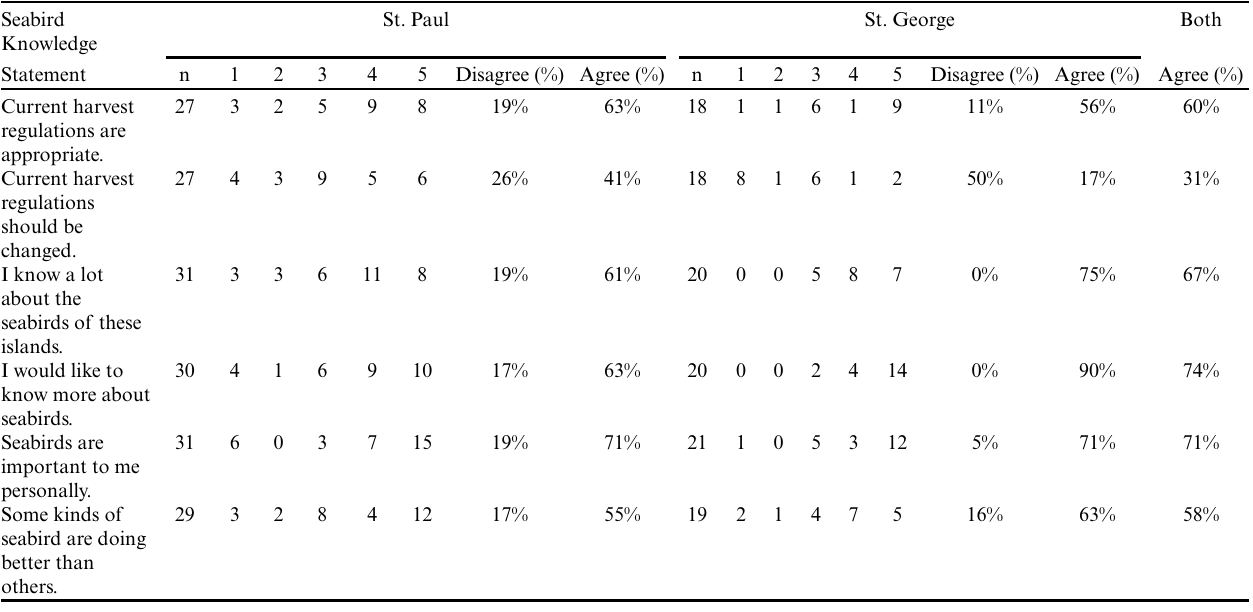
Table 4 . Survey responses to statements assessing knowledge of seabird biology and harvest regulations. For each island the sample size (n) responding to each question is given, along with the responses broken down according to the Likert scale: 1 = Disagree; 2 = Somewhat Disagree; 3 = Neither; 4 = Somewhat Agree; and 5 = Agree. For each statement the percent of responses agreeing and disagreeing is provided for each community. The last column indicates the percentage of responses in agreement with the statement in the entire